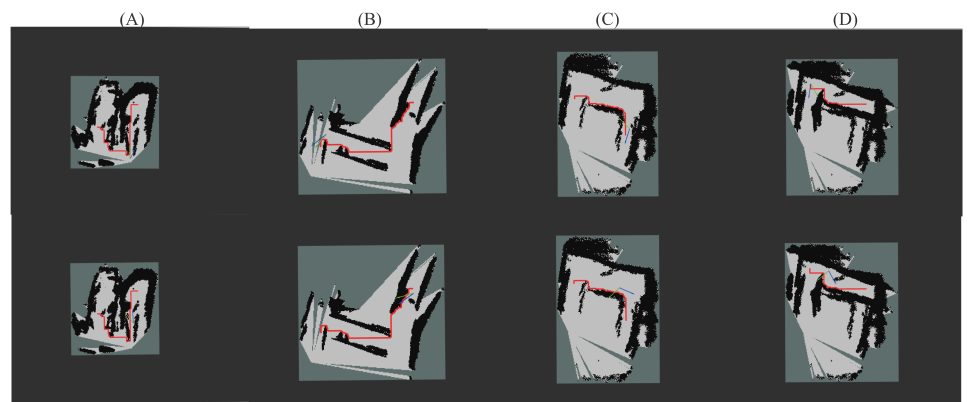
Figure 11. An illustration of the path planning and navigation in a ( A ) the U-shaped hallway; ( B ) the H-shaped hallway; ( C ) the Loop-shaped hallway; ( D ) the T-shaped